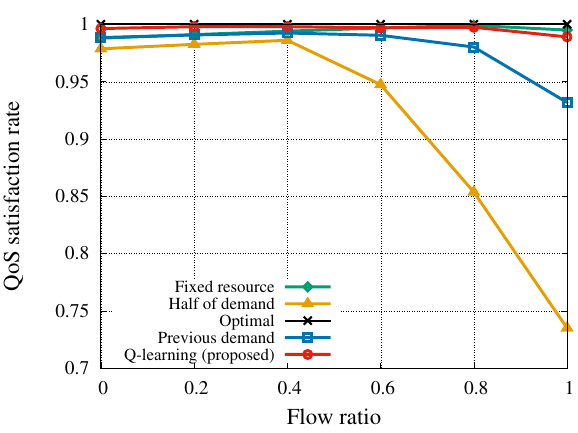
Figure 7. QoS satisfaction rate with respect to the flow